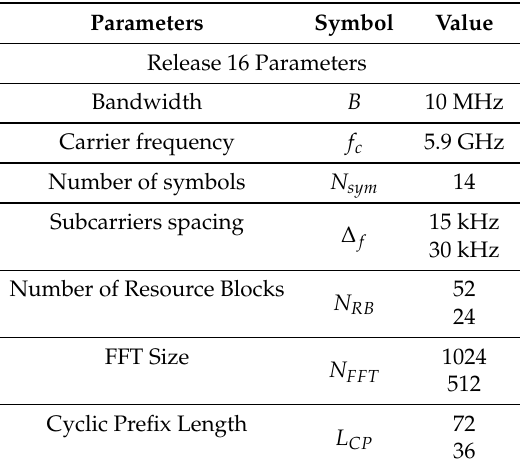
Table 2. Simulation